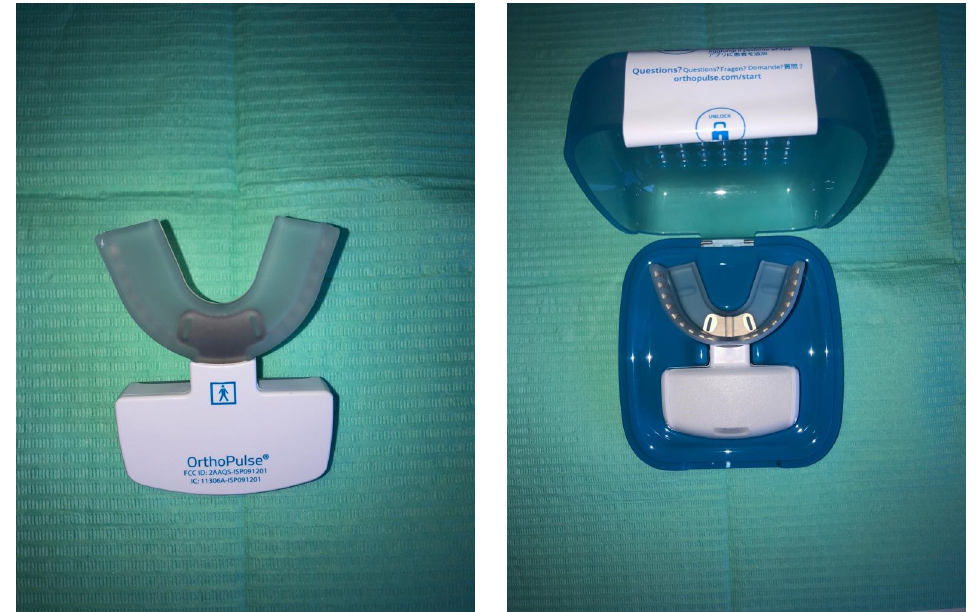
Figure 1. Orthopulse TM Device.